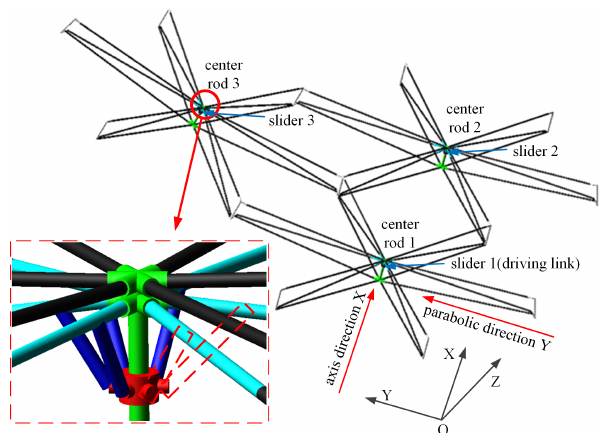
Figure 20. Deployable mechanism with three modules – based on the second design scheme.